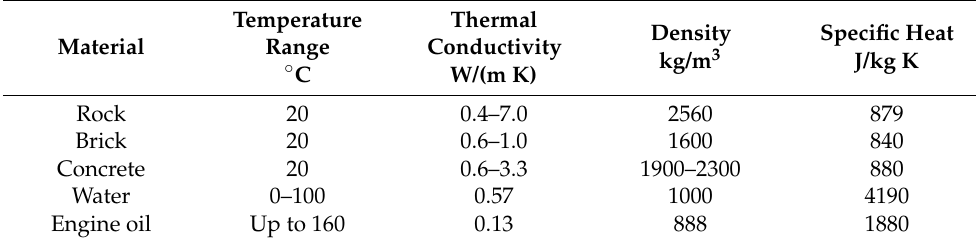
Table 1. The main parameters of selected solid–fluid materials for sensible heat storage [8–13].